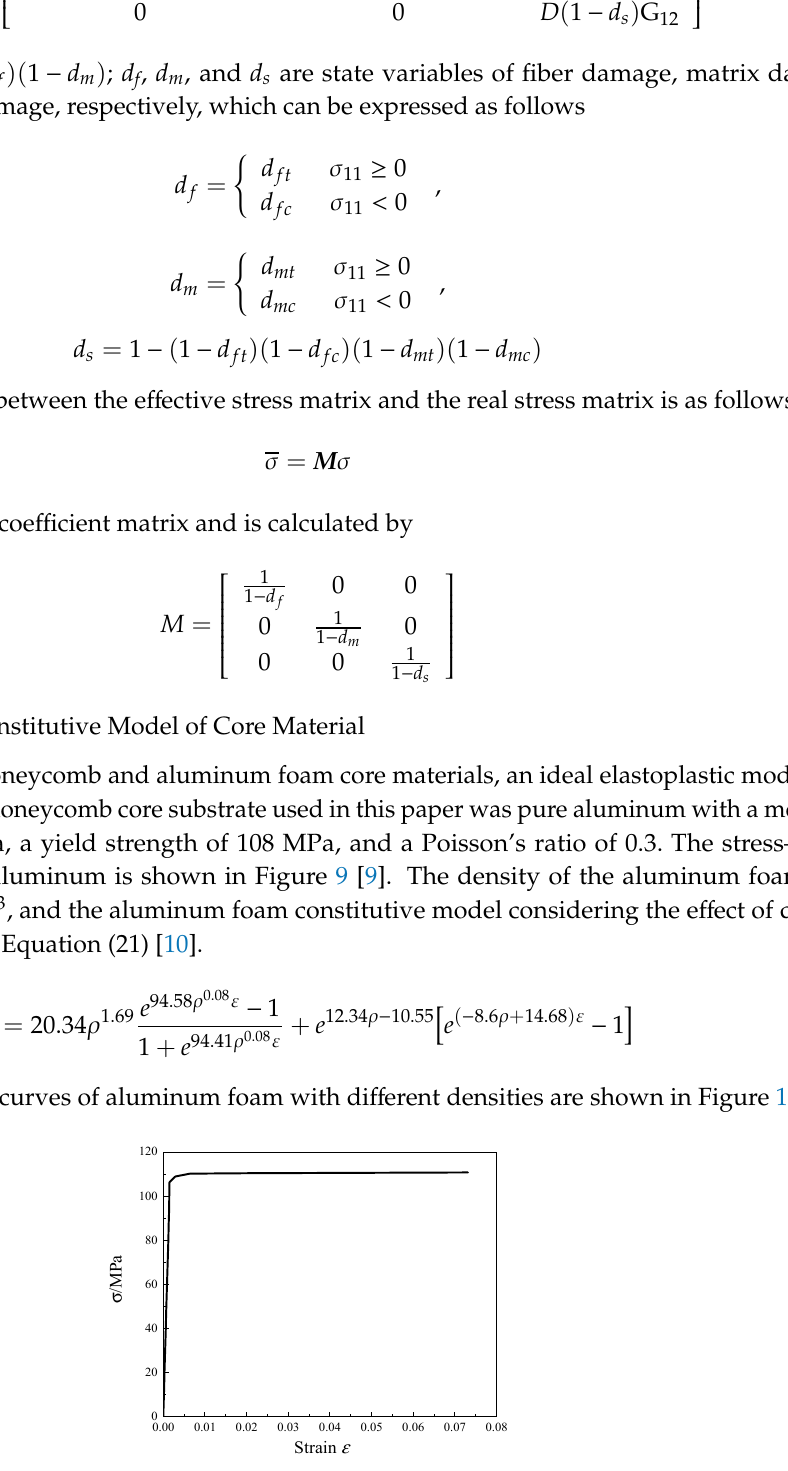
Figure 9. The stress–strain curve of the aluminum honeycomb matrix.